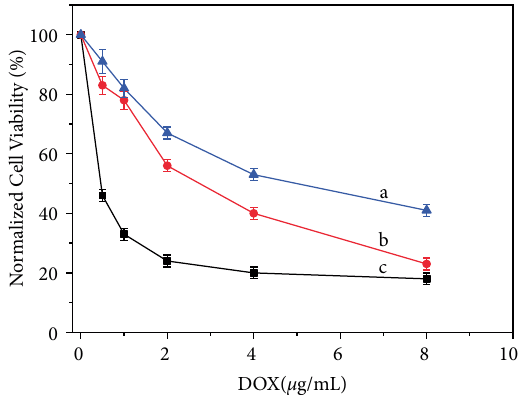
Figure 6: Cell viability of HeLa cells co-cultured with the free DOX (a) DOX-loaded hybrid MCNs modified with PEG (b) the DOX- loaded dual-targeting (FA) hybrid MCNs (c) for 48